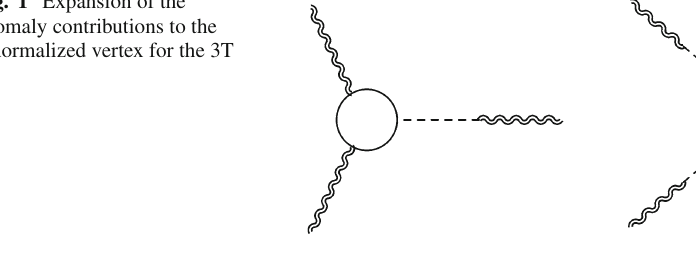
Fig. 1 Expansion of the anomaly contributions to the renormalized vertex for the